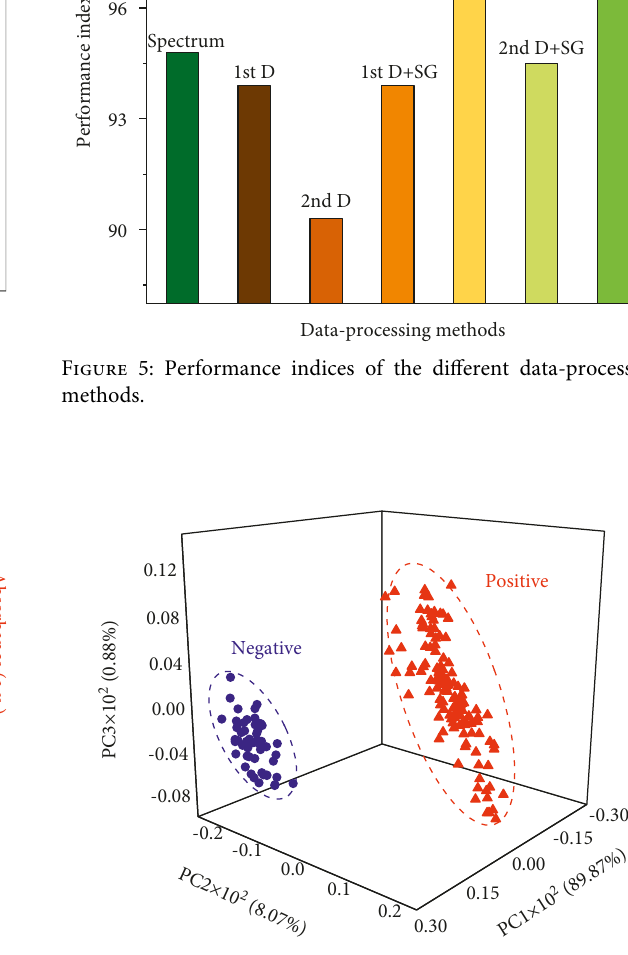
Figure 3: Near-infrared mean spectra of the positive and negative samples.